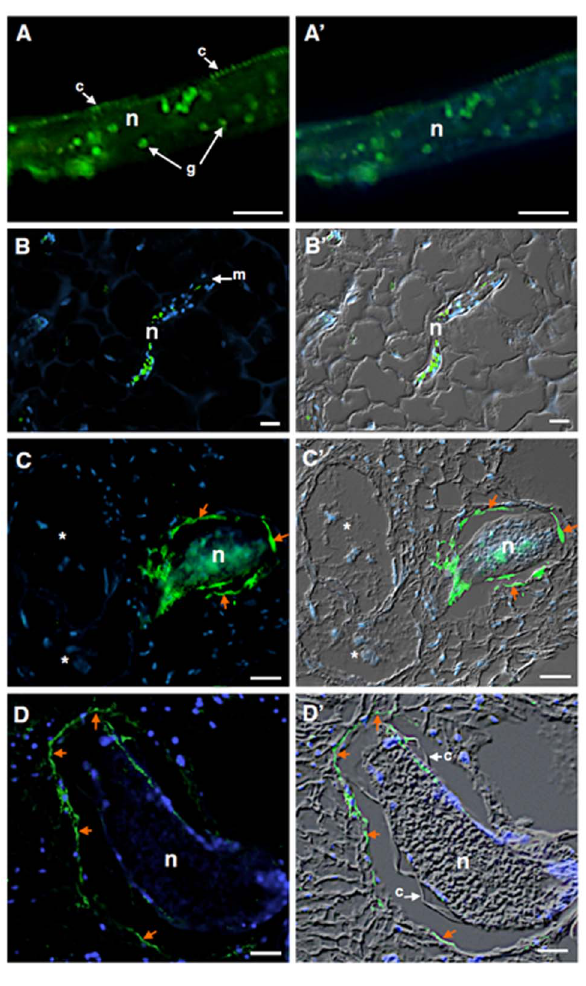
Figure 3. Immunodetection of FAR proteins in Meloidogyne incognita pre-parasitic J2 and during parasitism of Arabidopsis thaliana roots. ( A ) Cross nematode sections of pre-parasitic J2 displaying the protein localization at the nematode cuticle surface and circular granules structures within the posterior nematode body. ( B ) Localization of FAR proteins during nematode migration ( B-B 9 ), and nematode sedentary stages at 10 DAI ( C-C 9 ) and 21 DAI ( D-D 9 ) within the roots of A. thaliana . Arrows point out the accumulation of FAR along the nematode cuticle and adjacent cells surrounding the nematode body at 10 and 21 DAI. Micrographs on the left are overlays of Alexa-488 fluorescence (green) and DAPI-stained nuclei (blue). Micrographs on the right are overlays of an Alexa-488 fluorescence (green), DAPI-stained nuclei (blue) and differential interference contrast (grey). c , cuticle, g , granules, n , nematode, m , metacorpus, * giant cell. Bars=10 m m. doi:10.1371/journal.pone.0064586.g003 far-1 -RNAi tomato lines (Fig. S4). Infected tomato hairy root lines possessing the RNAi constructs demonstrate 80% reduction in mj- far-1 transcript compared with vector control as measured by qRT-PCR conducted with RNA extracted at 15DAI (Fig. S3C). To evaluate disease progress on tomato mj-far-1 -RNAi lines, both